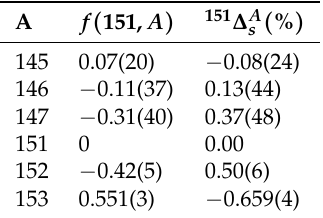
Table 1. Hyperfine anomalies for Eu isotopes, obtained from the work of Hühnerman et al. [26]. Only experimental errors are